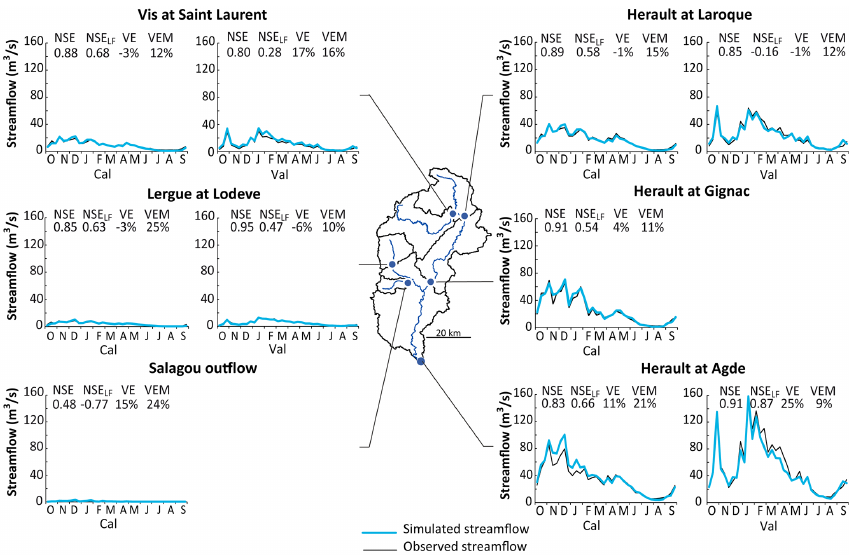
Figure 7. Simulation of influenced streamflow in the Hérault Basin from 1971 to 2009: results for the periods over which simulations of natural streamflow were calibrated (Cal: 1981–2009) and validated (Val: 1971–1980). Optimal values of NSE, NSE LF , VE, and VEM are 1, 1, 0 and 0,